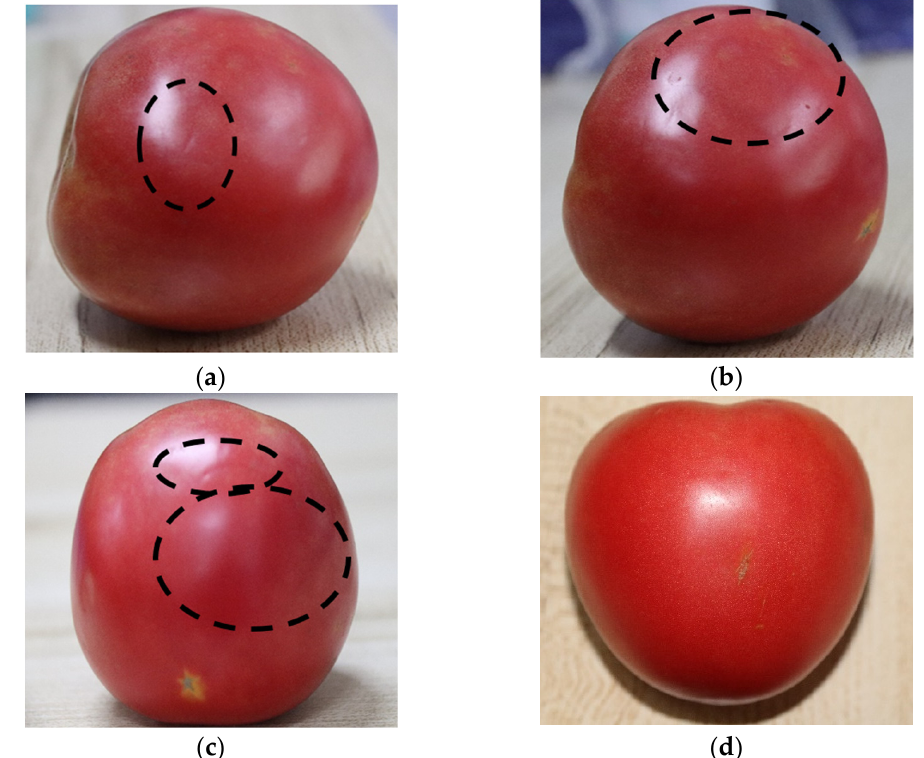
Figure 15. Tomato damage conditions ( a ) Indentation, ( b ) Bruises, ( c ) Indentation and Bruises, and ( d ) Normal ripe tomato.